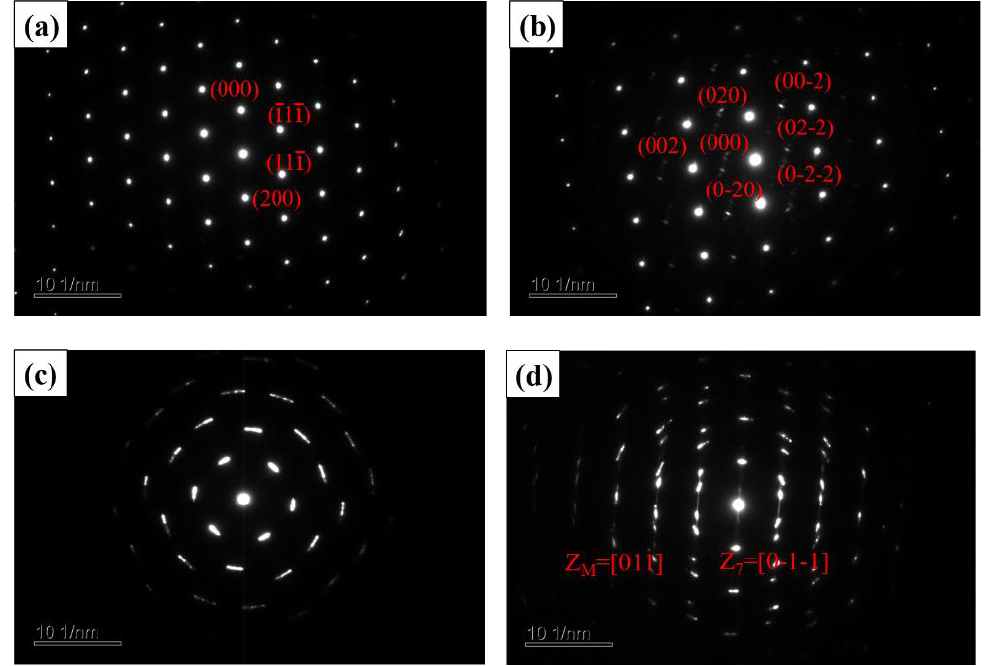
Figure 10. TEM selected area diffraction patterns of high-entropy alloy coatings. ( a , b ) CS coatings; ( c , d ) HVOF coatings.